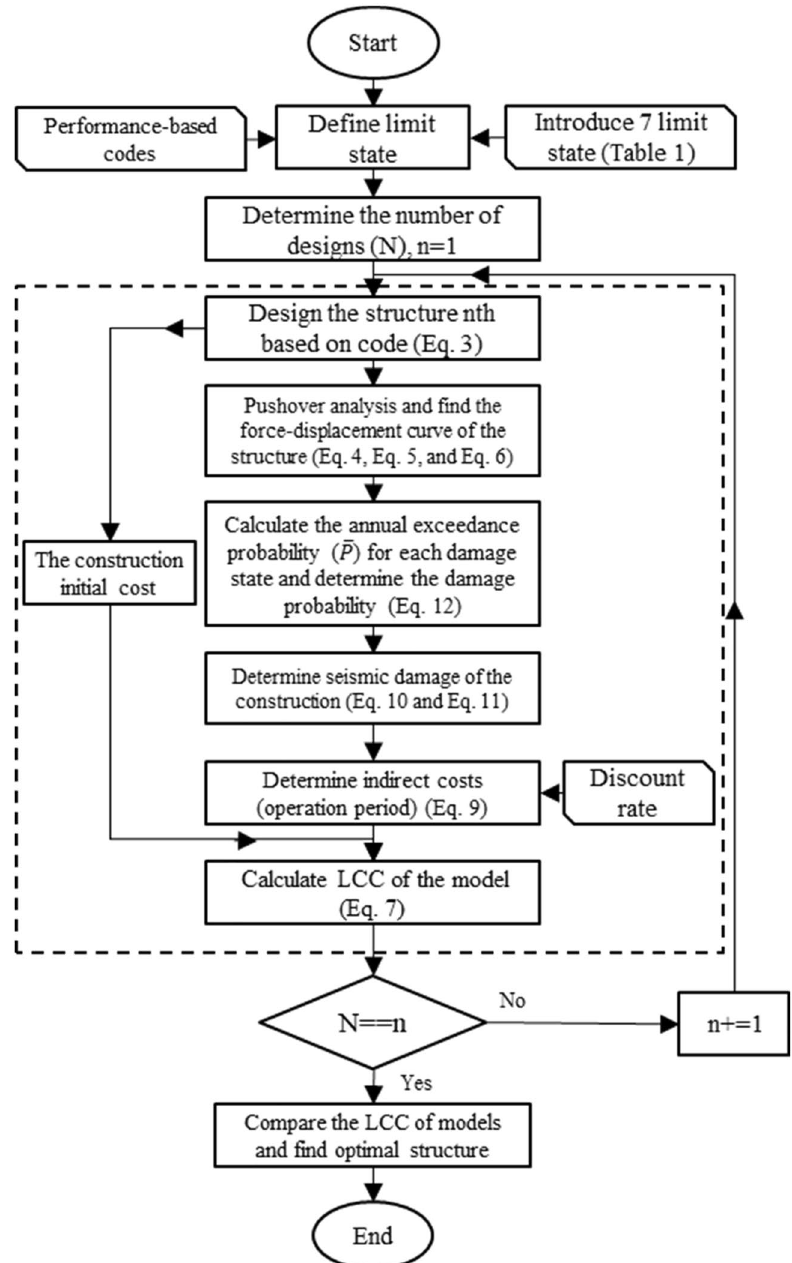
Figure 2. Flowchart of the optimization